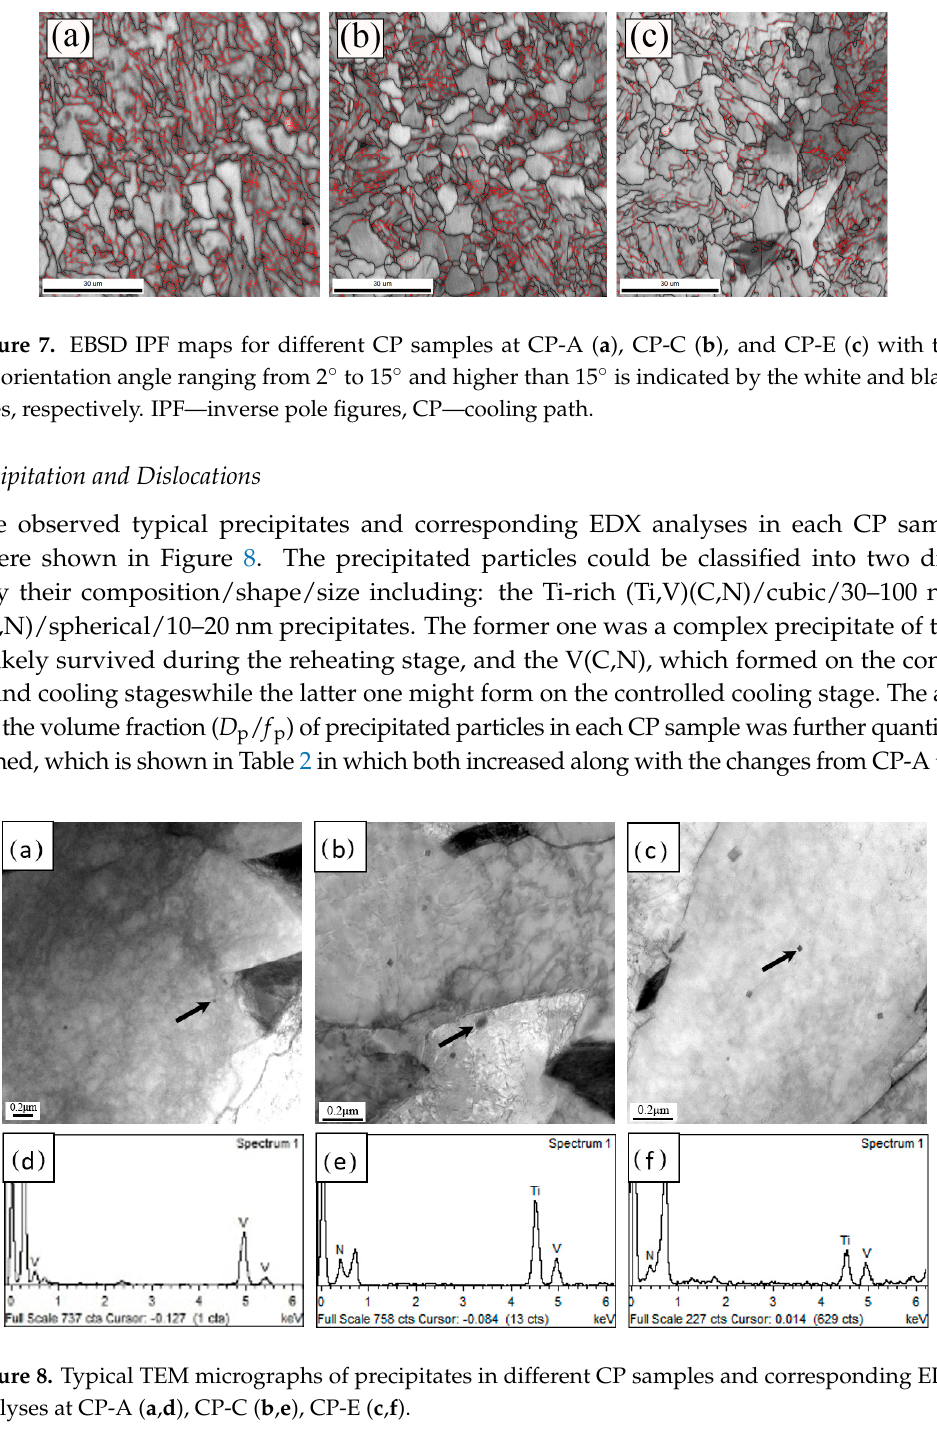
where ε represents nonuniform strain and b is the Burgers vector for the dislocation in α ‐ phase. Both ε and b were determined by XRD line profiles [20].